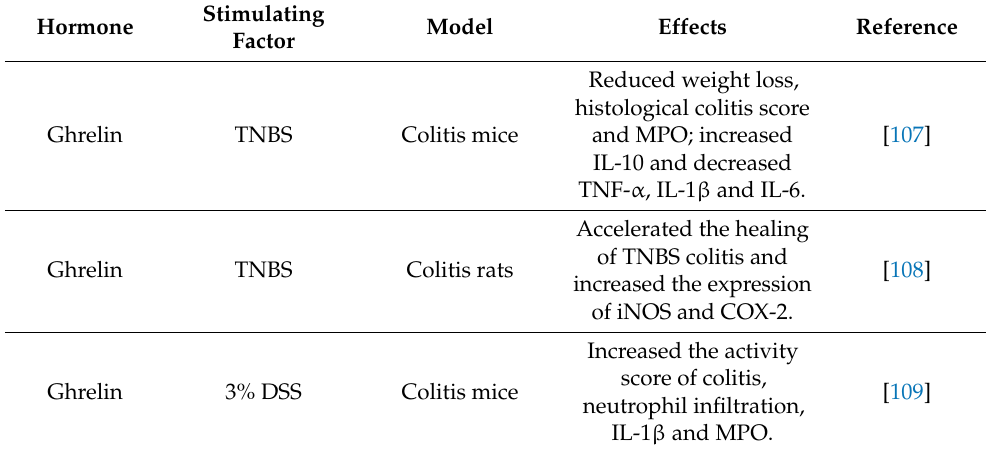
Table 3. Modulation of IBD by